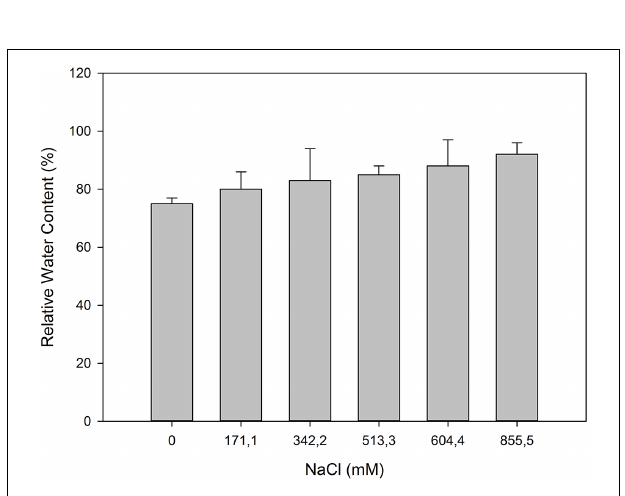
FIGURE 3 | Relative water content in photosynthetic stems of S. fruticosa , which was exposed to increased salinity levels (average ± SE, N =